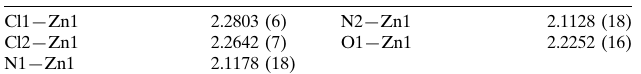
Selected bond lengths (A˚